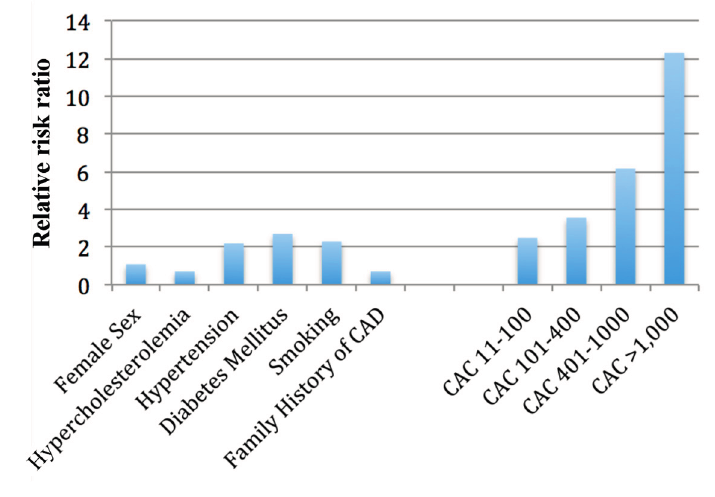
Figure 1. Predictive value of coronary artery calcium